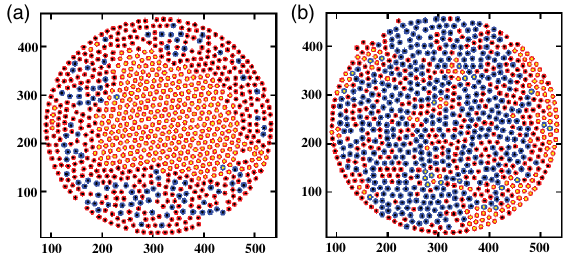
FIG. 11. Phase behavior of mixtures of rubber and steel balls. (a) Snapshot of a 1 ∶ 7 mixture of steel and rubber balls (the total area fraction of ϕ ¼ 0 . 72 ) driven at Γ ¼ 3 . 3 . Here, we can see a coexistence of the solid phase purely made of rubber balls and the liquid phase which is a mixture of steel and rubber balls. (b) Snapshot of a 1 ∶ 1 mixture of steel and rubber balls (the total area fraction of ϕ ¼ 0 . 72 ) driven at Γ ¼ 3 . 3 . The color of the outer shell of each particle represents the type of the particle (blue, steel ball; red, rubber ball), whereas the color of the inner core represents the degree of the hexatic order (black, low ψ 6 ; yellow, high ψ 6